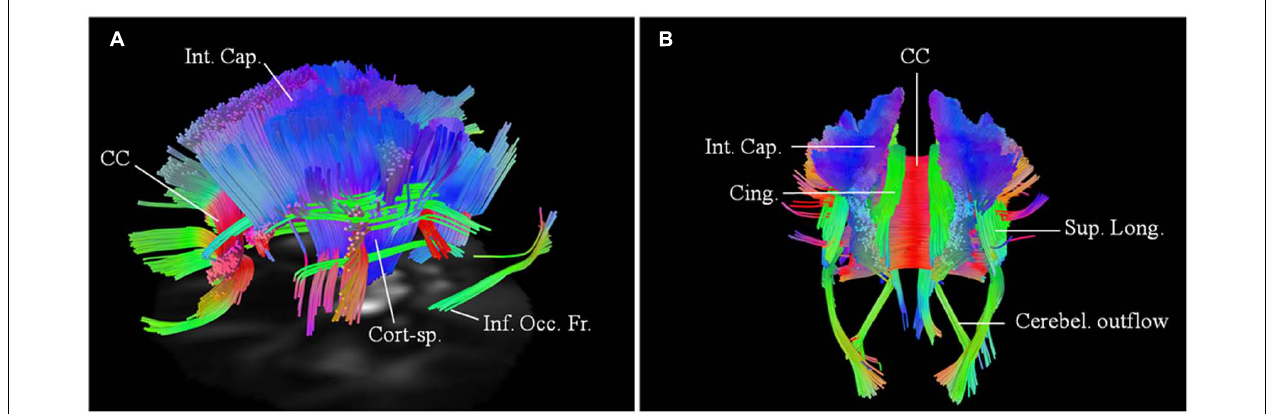
FIGURE 5 | Baseline scans in patients 4 (A, left lateral view) and 5 (B, posterior view) demonstrating bilateral changes in the motoric and extramotoric pathways, being more pronounced on the right. Bilateral involvement of the cerebellar outflow tracts (Cerebel. outflow) was noted in patient 5. Bilaterally involved tracts